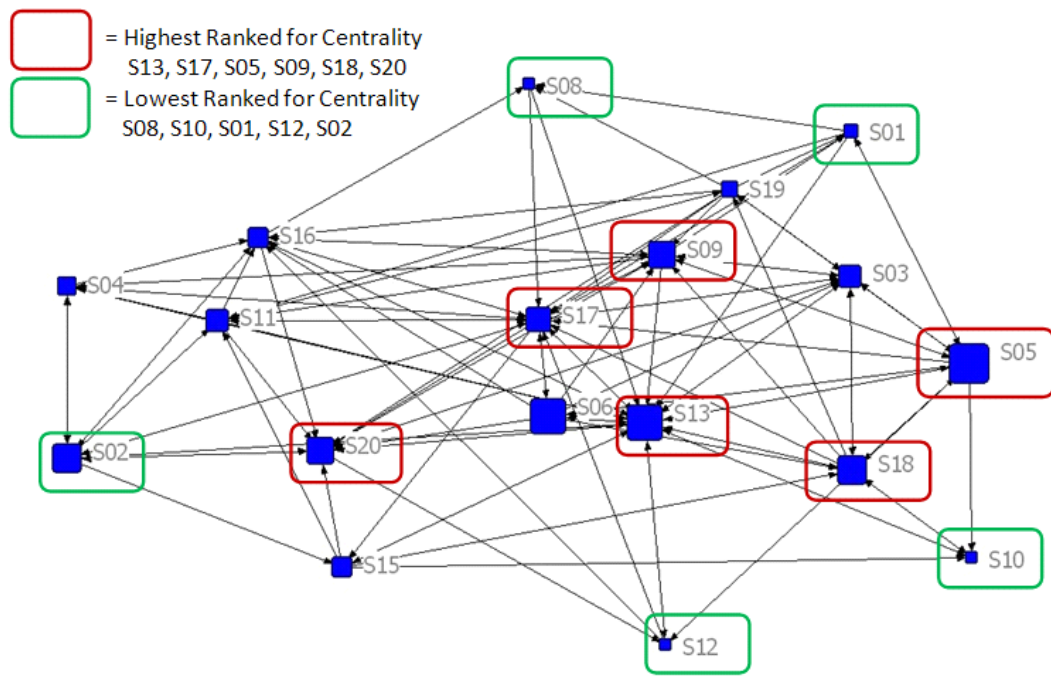
Figure 3 . Network graph: Module 6 discussions node size by combined discussion and journal LP and rankings for high vs. low